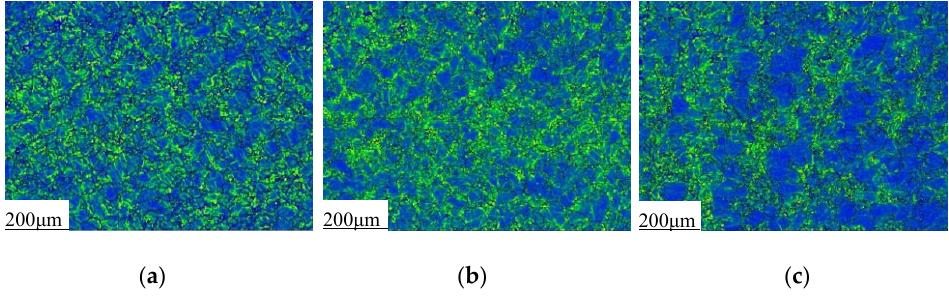
Figure 8. Local misorientation maps of different samples under axial tension of 0.08: ( a ) T0 sample, ( b ) T45 sample, ( c ) T90 sample.